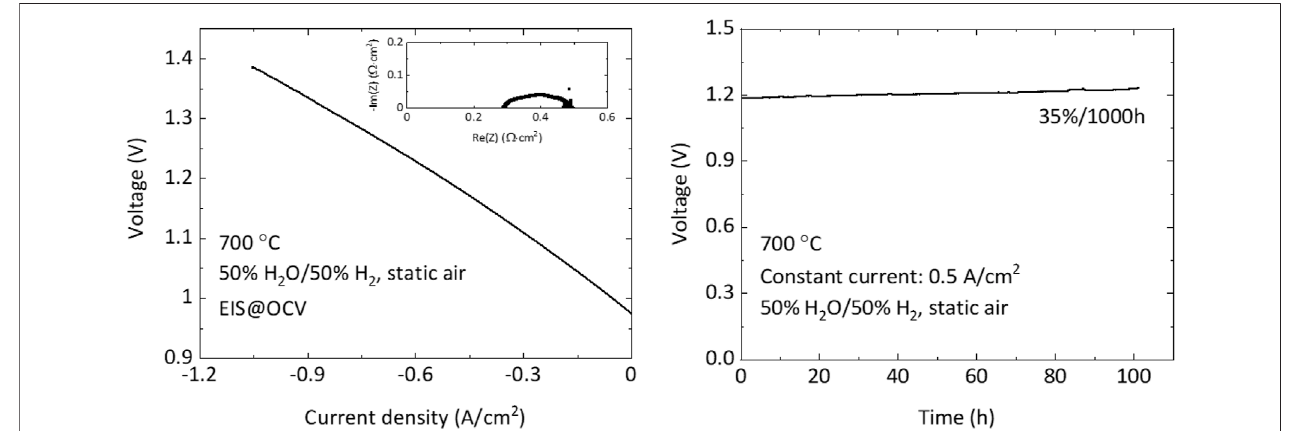
FIGURE 3 | An example of graphical data reporting. (A) I-V plot with EIS at OCV (~0.97 V); (B) Durability.